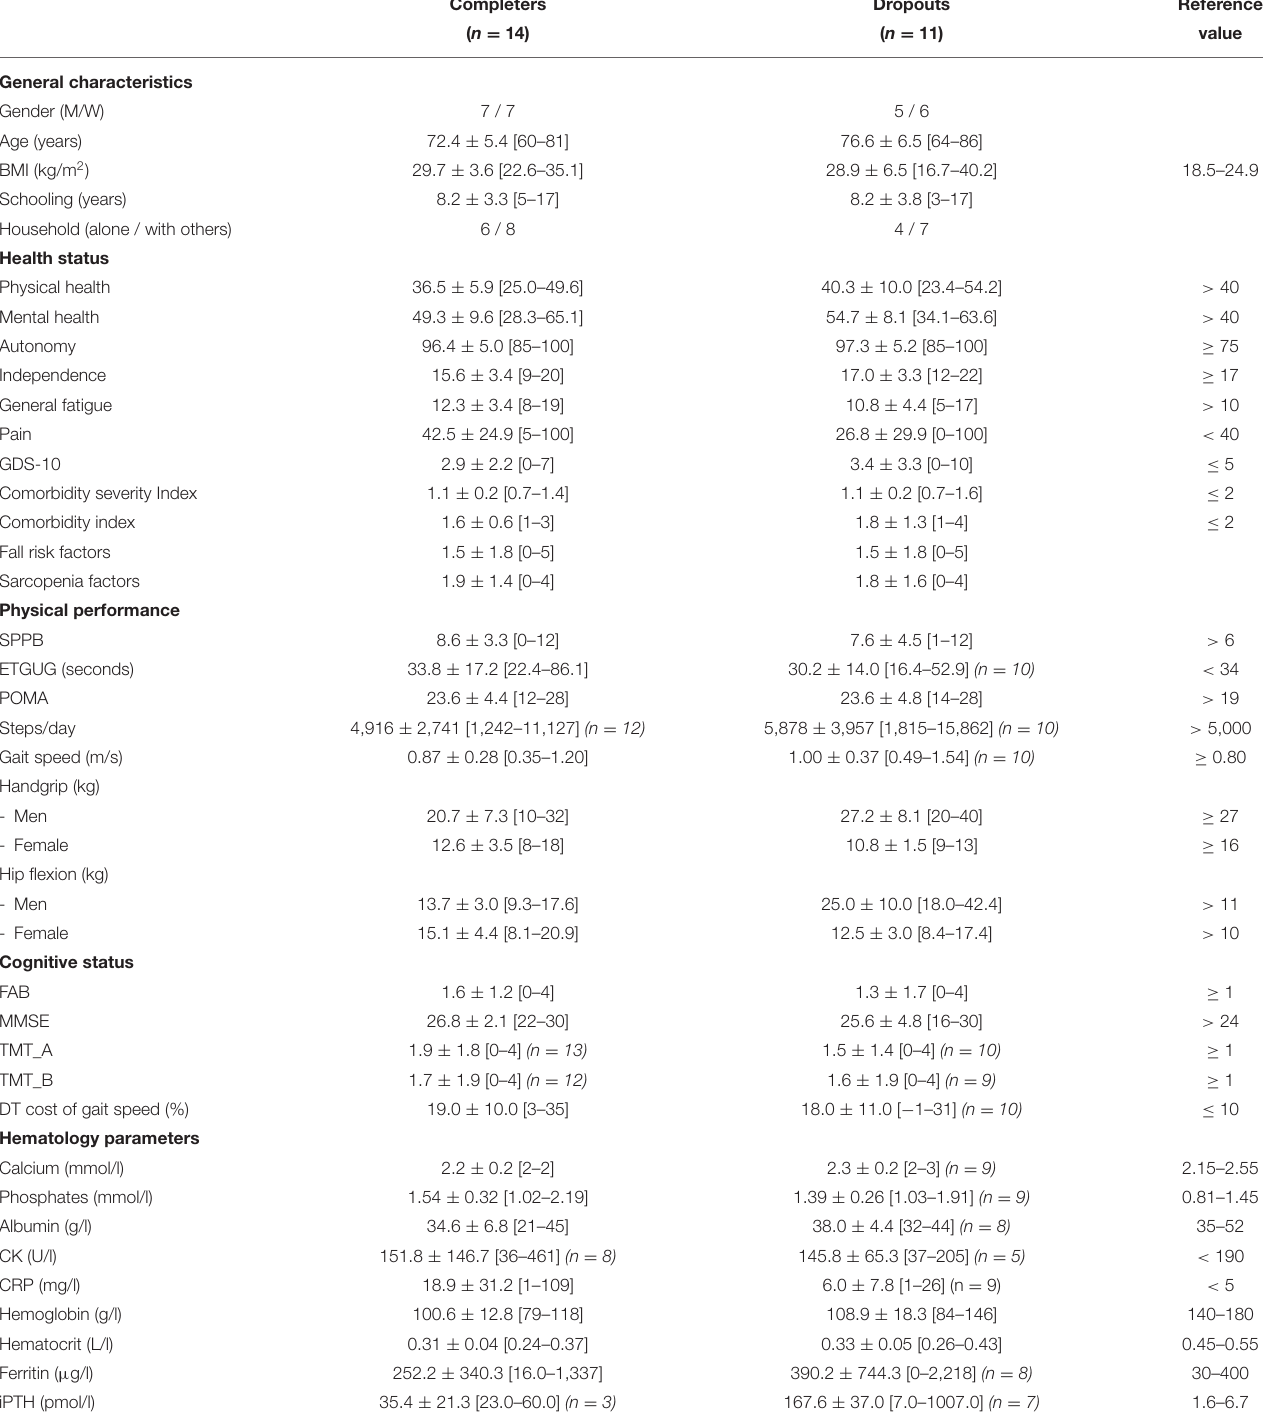
TABLE 1 | Main demographic, clinical and functional data [mean ± SD (min–max)] at baseline by